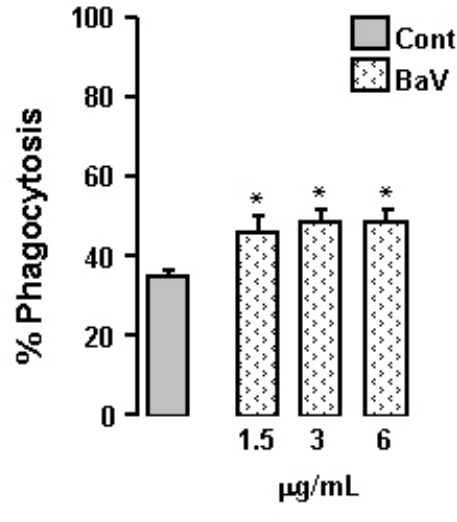
Figure 3. Effect of BaV on phagocytosis of opsonized zymosan particles in thioglycollate-elicited macrophages. Thioglycollate-elicited macrophages harvested 96 hours after intraperitoneal injection of thioglycollate were incubated with BaV or RPMI (control) for 60 minutes before addition of opsonized zymosan particles. Values are mean ± SEM from four animals. * p < 0.05 compared to controls (ANOVA).